Question: Draft a figure caption describing what is shown.
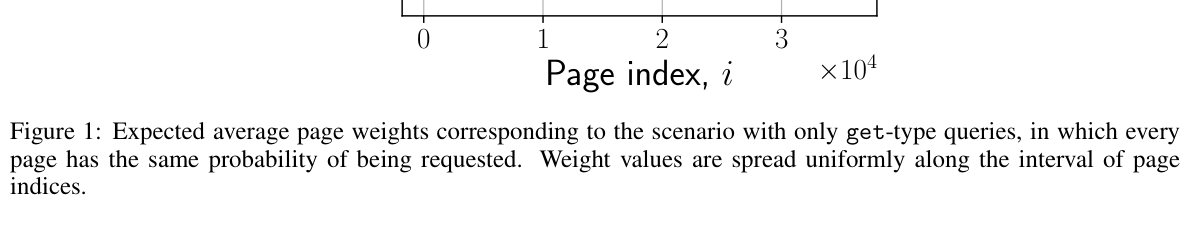
Answer: demonstrates that EEvA-T and EEvA-Greedy algorithms show the best performance regarding the miss rate and averaged time cost (see (4)). We observe the gap in both metrics that highlights the gain from the proposed EEvA-based eviction strategies. Although our algorithms can process scan-type queries properly, this experiment demonstrates high performance for the get-only scenario. In the next paragraphs, we show how the expected averaged page weights and the performance of the considered algorithms are changed if the scan-type queries appear in the trace.